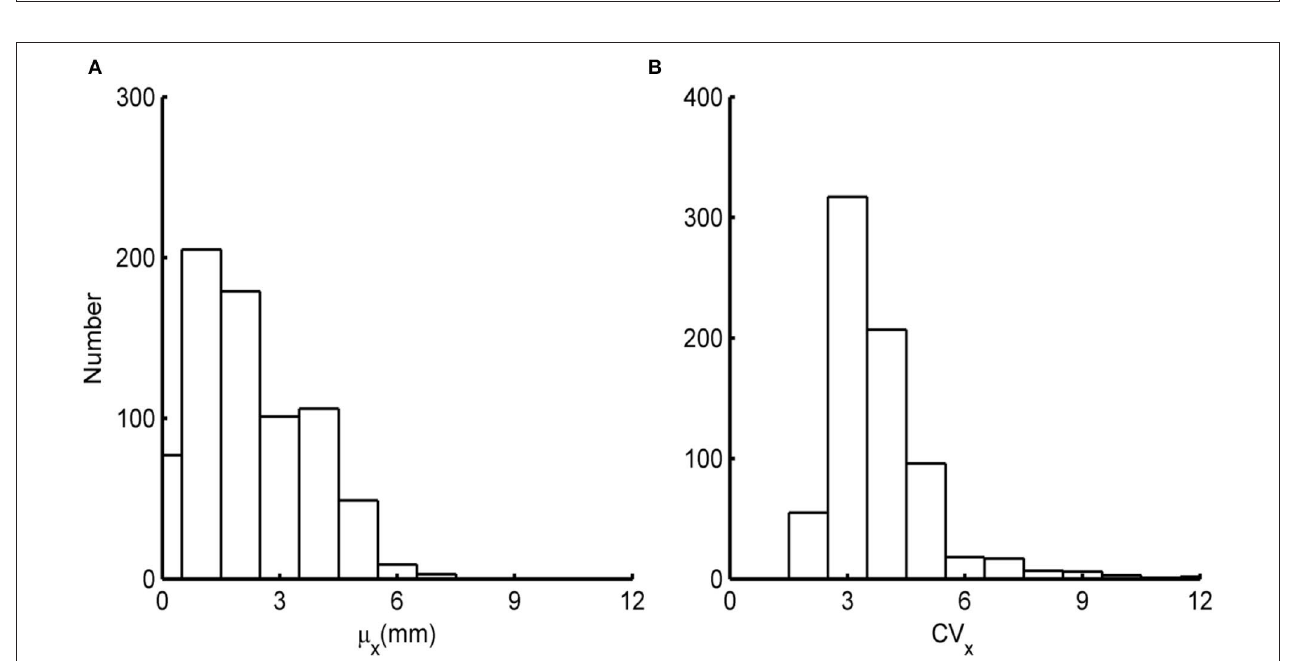
FIGURE 4 | Histogram for daily (A) µ X and (B) CV X of 665 precipitation records studied.